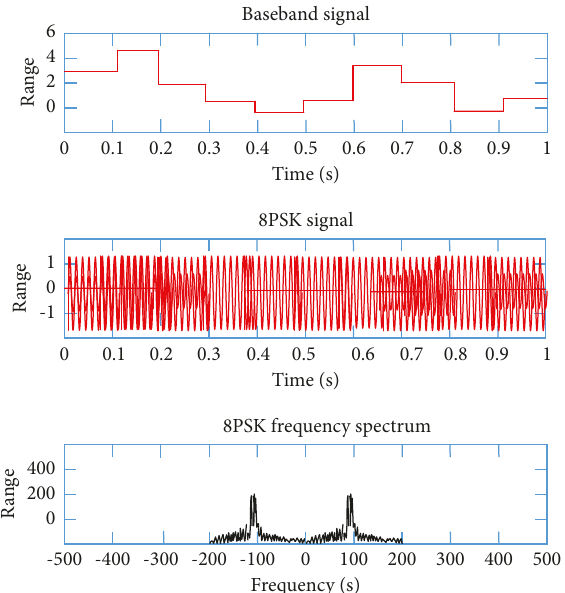
Figure 6: 8PSK time-domain waveform and